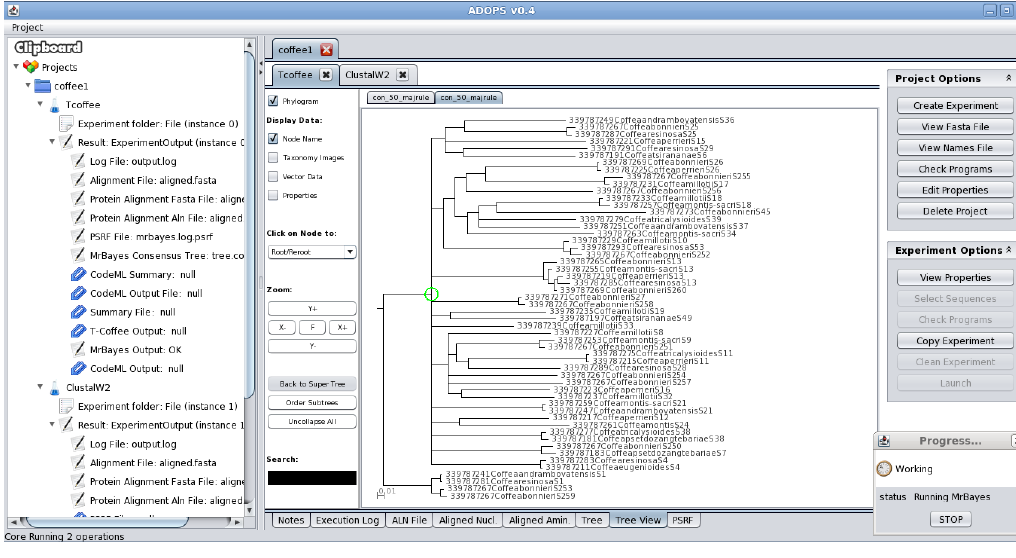
Figure 3: Phylogenetic tree visualization with